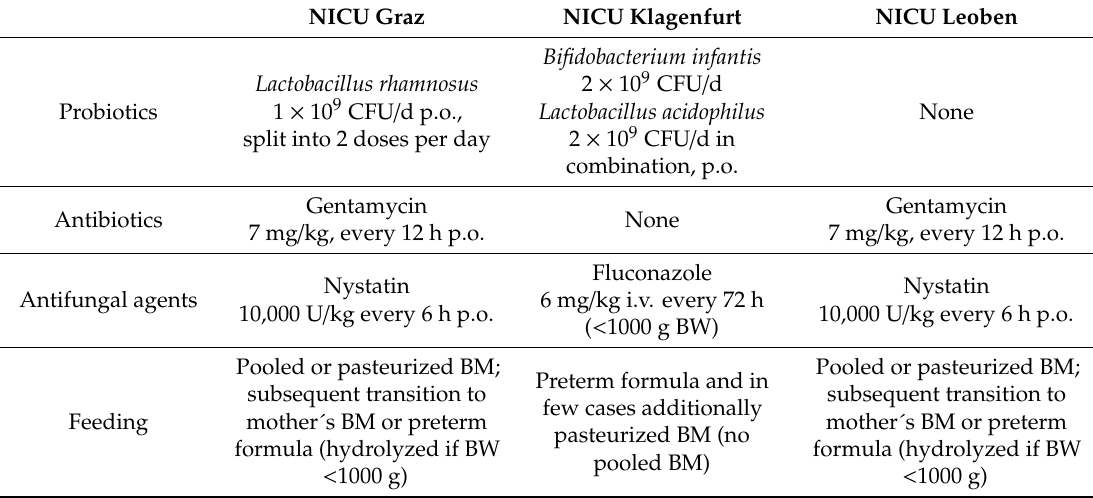
Table 1. Regimens regarding administration of medication, feeding and probiotic treatment at the three Neonatal Intensive Care Units (NICUs). p.o.: per os (oral); BM: breast